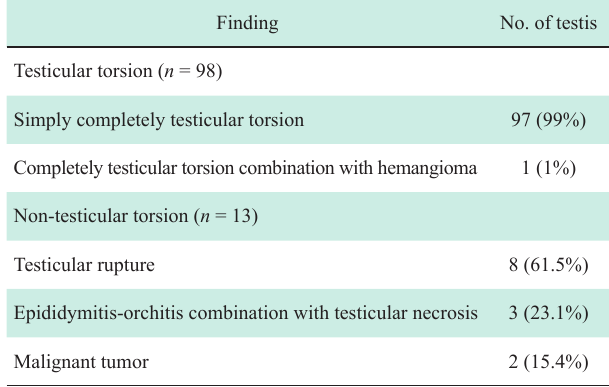
Table 1 Surgical or surgical-histopathologic findings from 111 testes with absent blood flow detected by color Doppler ultrasound Finding